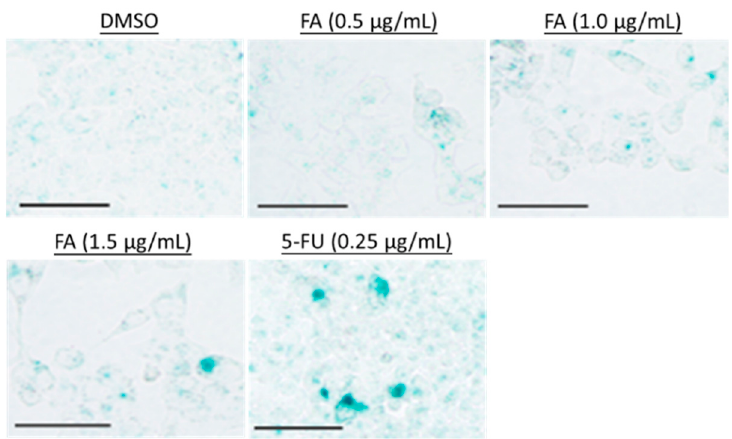
Figure 4. Evaluation of cell cycle distribution. HCT-116 cells were treated with DMSO (0.5%) or FA (0.75–1.5 μ g/mL) for 12 h prior to flow cytometric analysis. Shown here are representative distributions from three independent trials. In the pie charts, grey sections denote the S phase, blue sections denote the G1 phase, and orange sections denote the G2 phase.